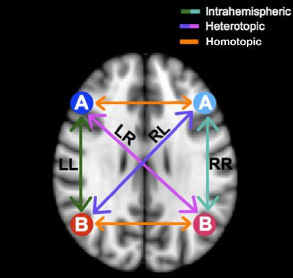
Figure 2. Comparison of Mirrored Voxels across Hemispheres in a Symmetrical Brain using